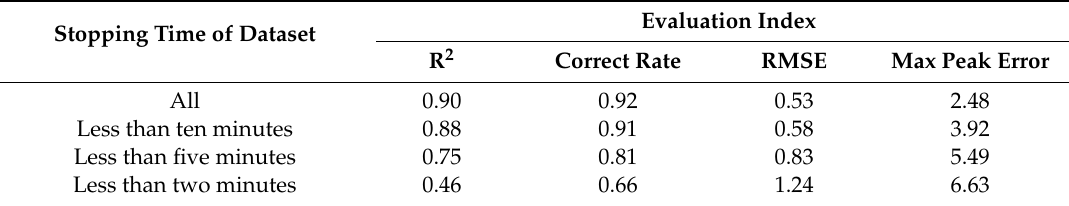
Table 20. Evaluation index value when the stopping time of training data was excluded.